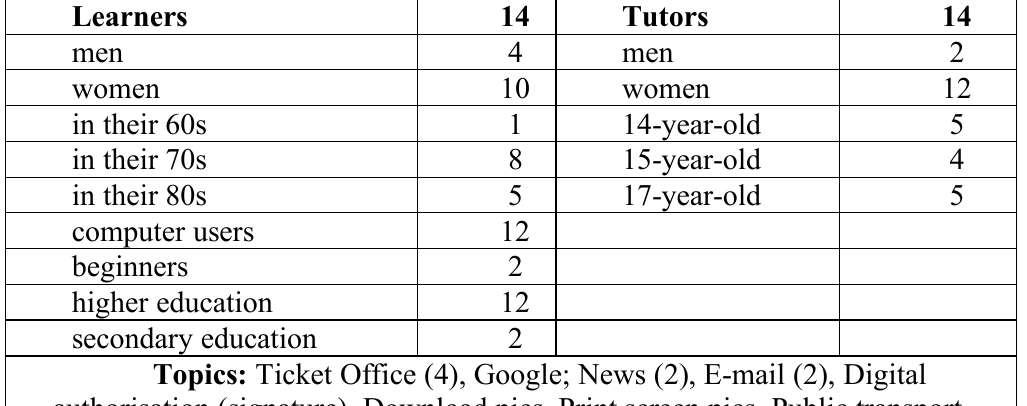
Table 1. Profiles of the participants and learning